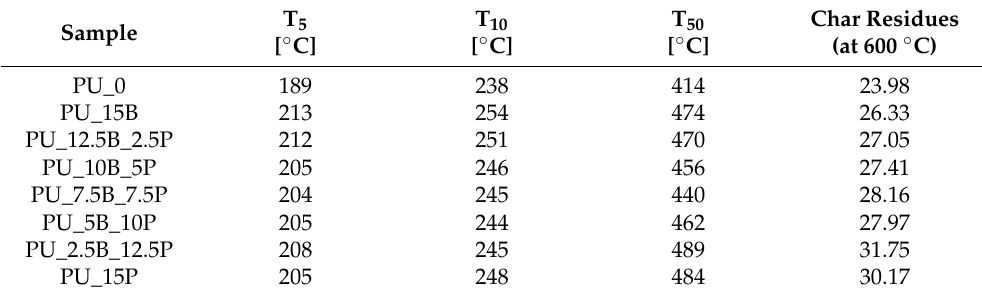
Table 3. The results of the thermogravimetric analysis of rigid PU foams.